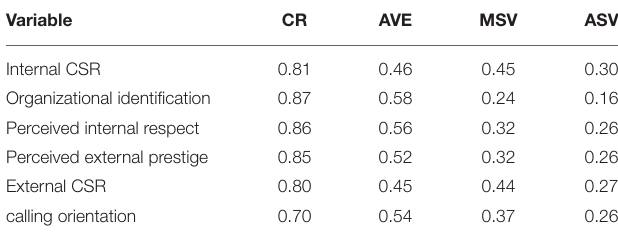
TABLE 2 | Reliability and